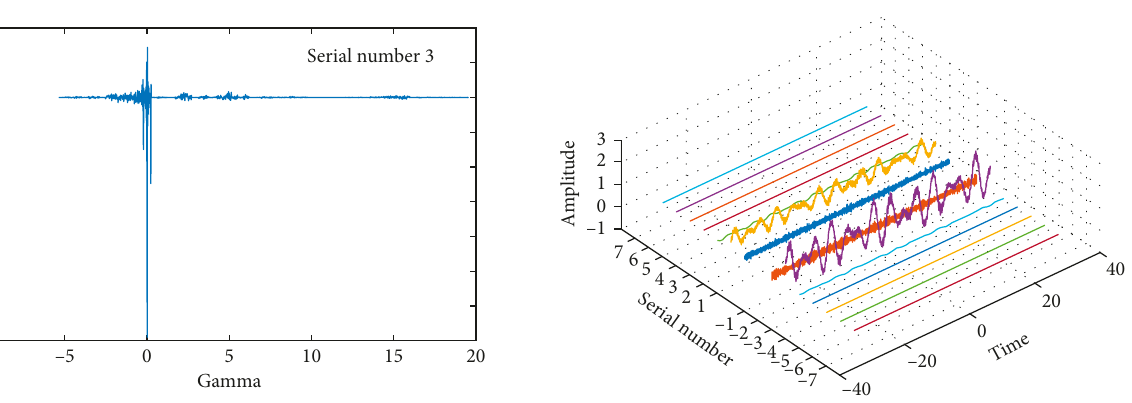
Figure 13: The real part of the new positive filtered signal in the frequency domain.